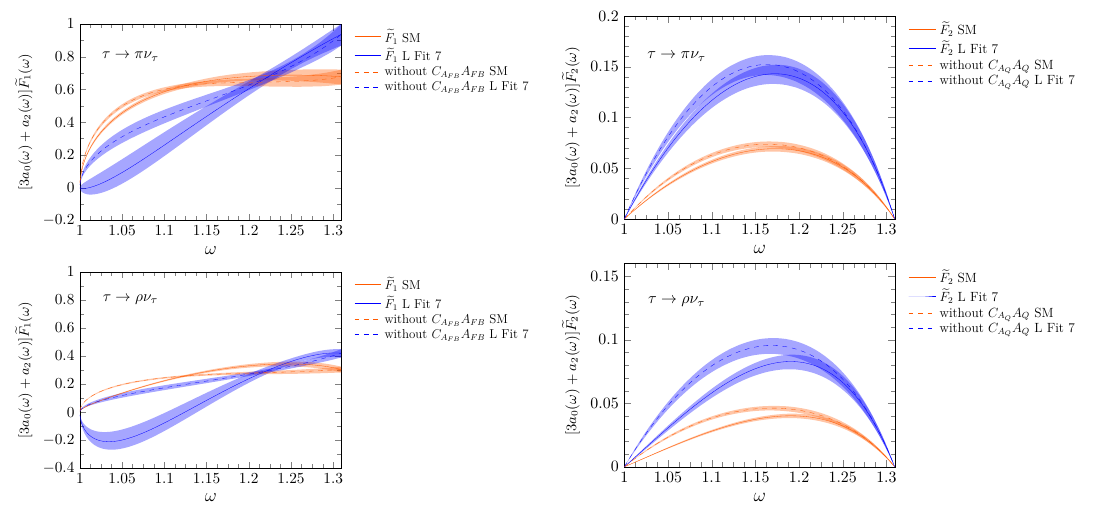
Figure 4 . Same as figure 3, but for the [3 a 0 ( ω ) + a 2 ( ω )] e F π,ρ use the expressions for the coefficients collected in appendix A, which were obtained keeping the pion and rho meson masses